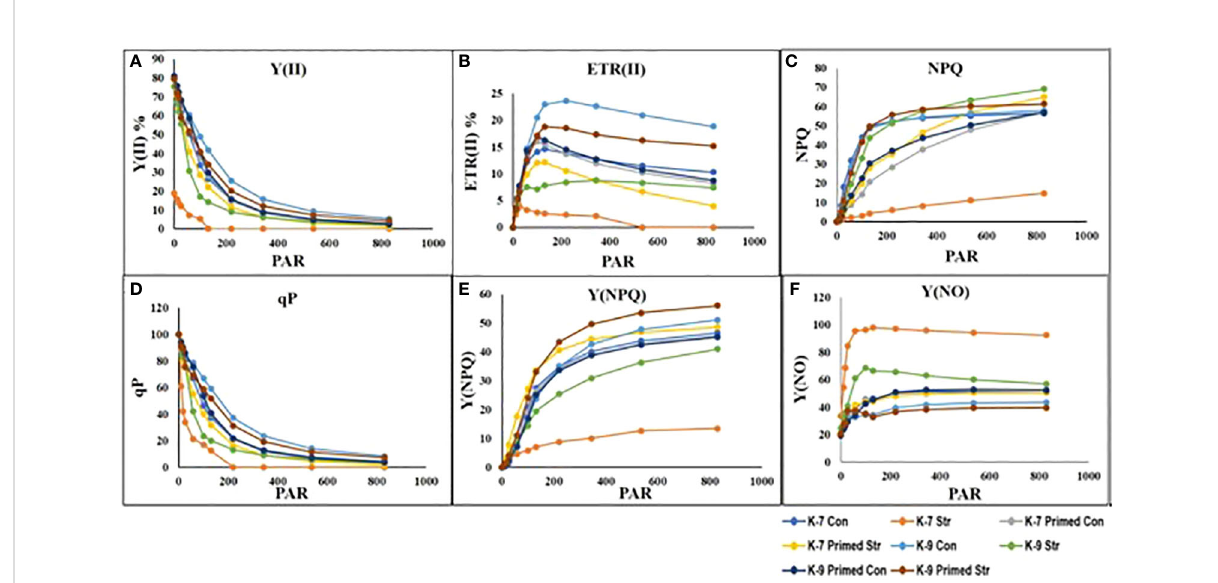
FIGURE 7 Changes in rapid light curves of photosynthetic parameters (A-F) in melatonin-primed or unprimed drought-sensitive (K-7) and drought-tolerant (K-9) varieties of groundnut in optimal conditions (control) or after exposure to drought stress. (A) Effective photochemical quantum yield [Y (II)]; (B) Electron transport rate of PSII [ETR(II)]; (C) Non-photochemical quenching (NPQ); (D) Photochemical quenching (qP); (E) Regulated heat dissipation Y(NPQ); and (F) Non-regulated heat dissipation [Y(NO)]. PAR is photosynthetically active